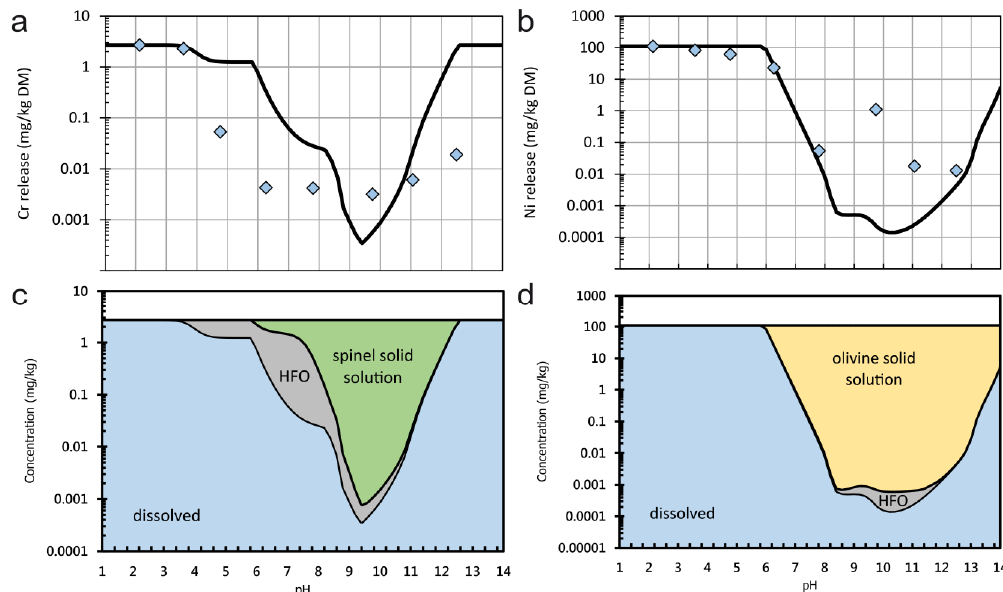
Figure 9. ( a ) Concentration of Cr in solution as a function of pH for sample C n ; ( b ) concentration of Ni in solution as a function of pH for sample C n ; ( c ) phases which are suggested to control the leachability of Cr in sample C n by precipitation / dissolution or adsorption / desorption equilibria. HFO: hydrous ferric oxides; ( d ) phases which are suggested to control the leachability of Ni in sample C n by precipitation / dissolution or adsorption / desorption equilibria. Symbols indicate measured and lines and modelled dissolved concentrations.